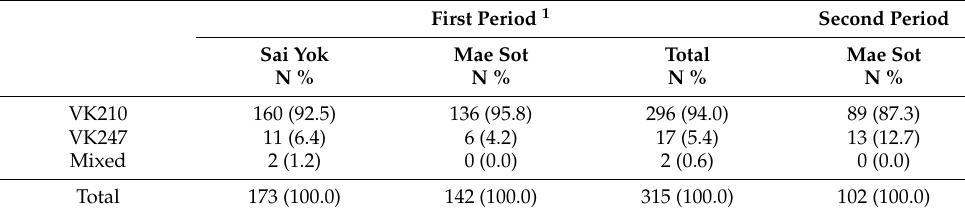
Table 1. The proportion of PvCSP from the first (2006–2007) and second (2014–2016) periods.